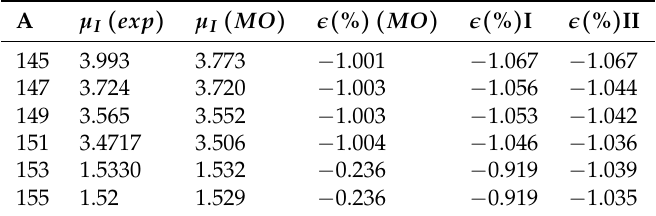
Table 4. Magnetic moments and Bohr–Weisskopf effect for odd Eu isotopes. MO denotes values obtained from particle-rotor calculations and I and II values from